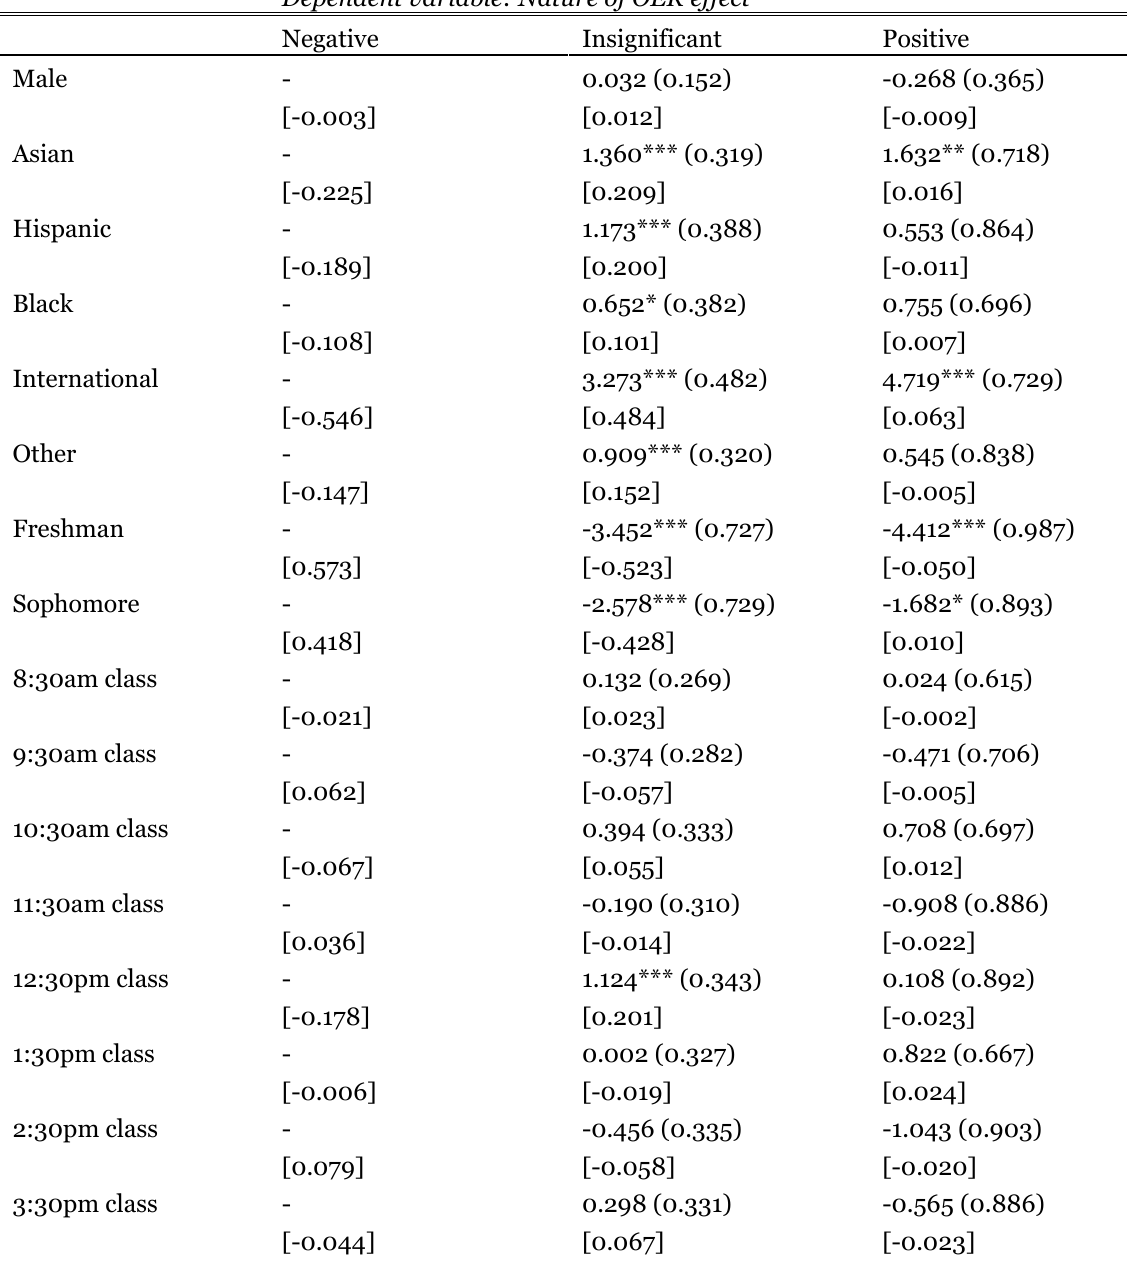
Multinomial Logit Regression Estimates and Implied Marginal